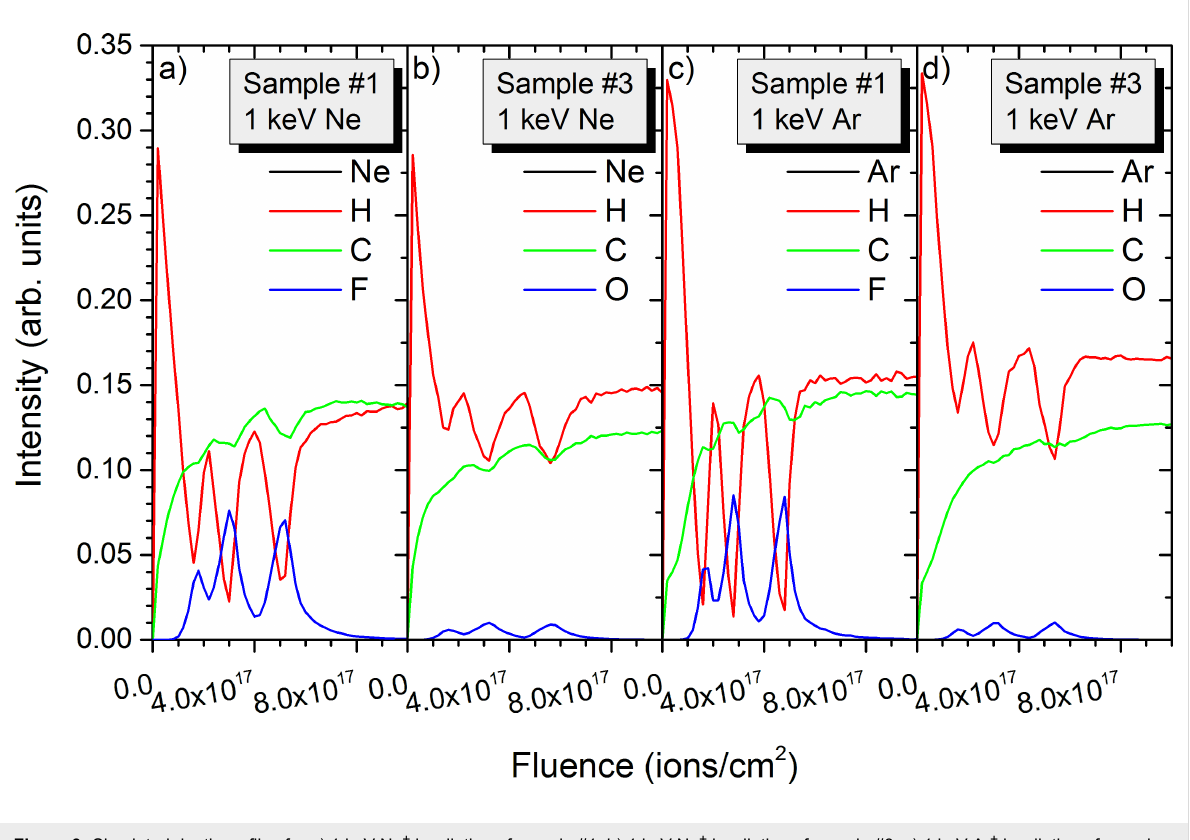
Figure 9: Simulated depth profiles for a) 1 keV Ne + irradiation of sample #1, b) 1 keV Ne + irradiation of sample #3, c) 1 keV Ar + irradiation of sample #1, and d) 1 keV Ne + irradiation of sample #3. All samples have inter-layer spacing of 10 nm and 20 nm.